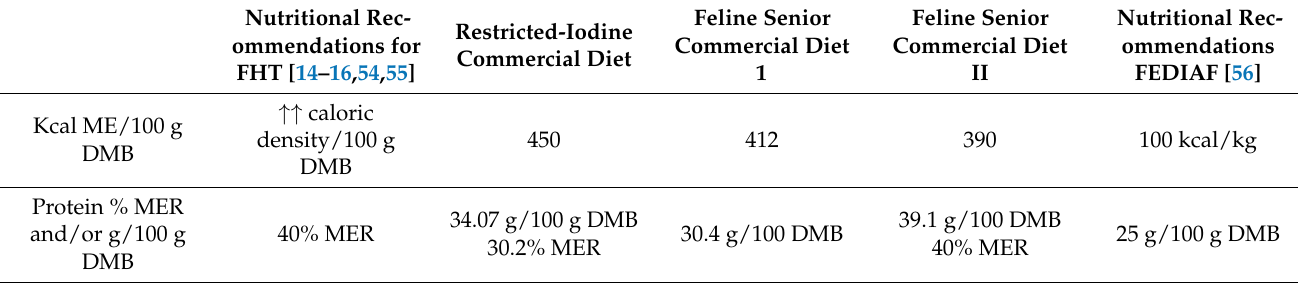
Table 3. Nutritional values of three feline commercial diet and comparison with recommendations from [14–16,54,55] and FEDIAF guidelines 2020 [56]. The dark red text identifies the closest value to Peterson’s recommendations for nutritional management of